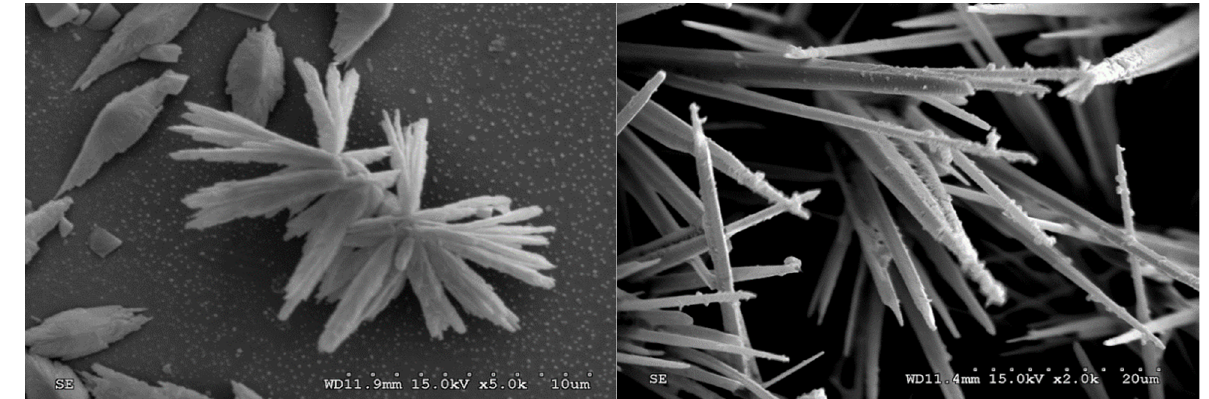
Figure 11. SEM image of aragonite crystals with and without electromagnetic treatment